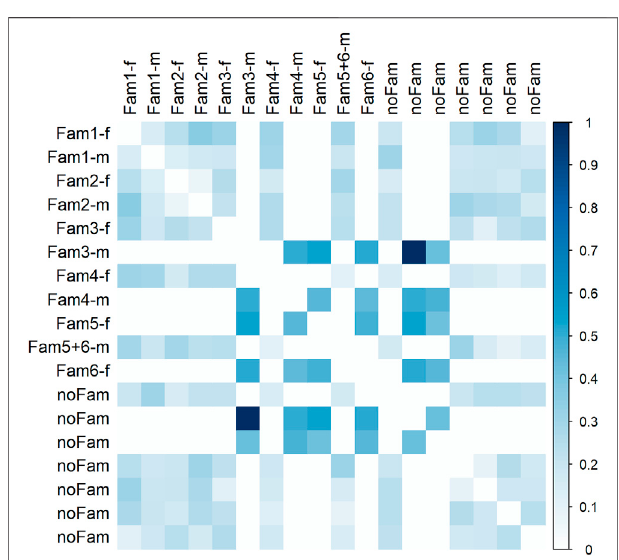
FIGURE 5 | Relatedness matrix for the parent population. Column and row names refer to family assignment. In case of “ noFam, ” an individual was not used for mating; extension -f indicates females and -m males.